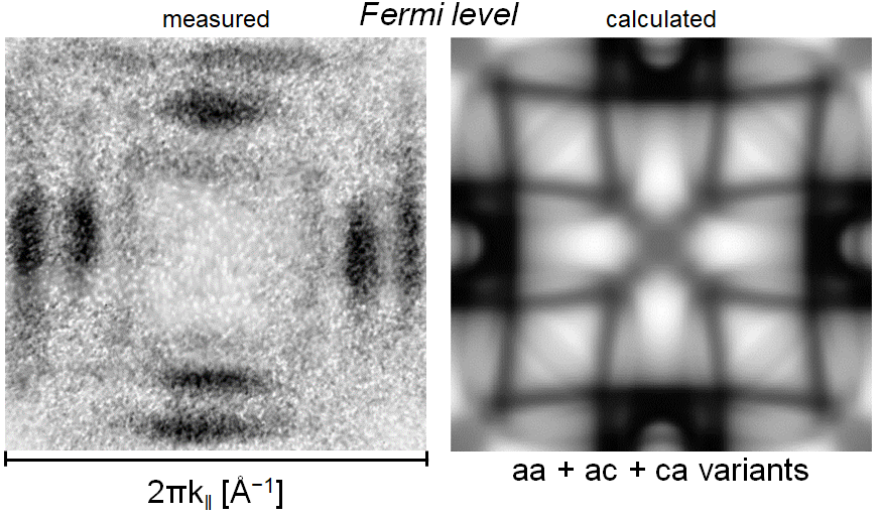
Figure 3. Photoemission intensity from martensitic phase at Fermi level measured ( left ) and calcu- lated ( right ). The displayed intensities are relative quantities. Therefore, they do not allow a direct quantitative comparison between experiment and theory. The theoretical intensity is taken from Ref. [12].